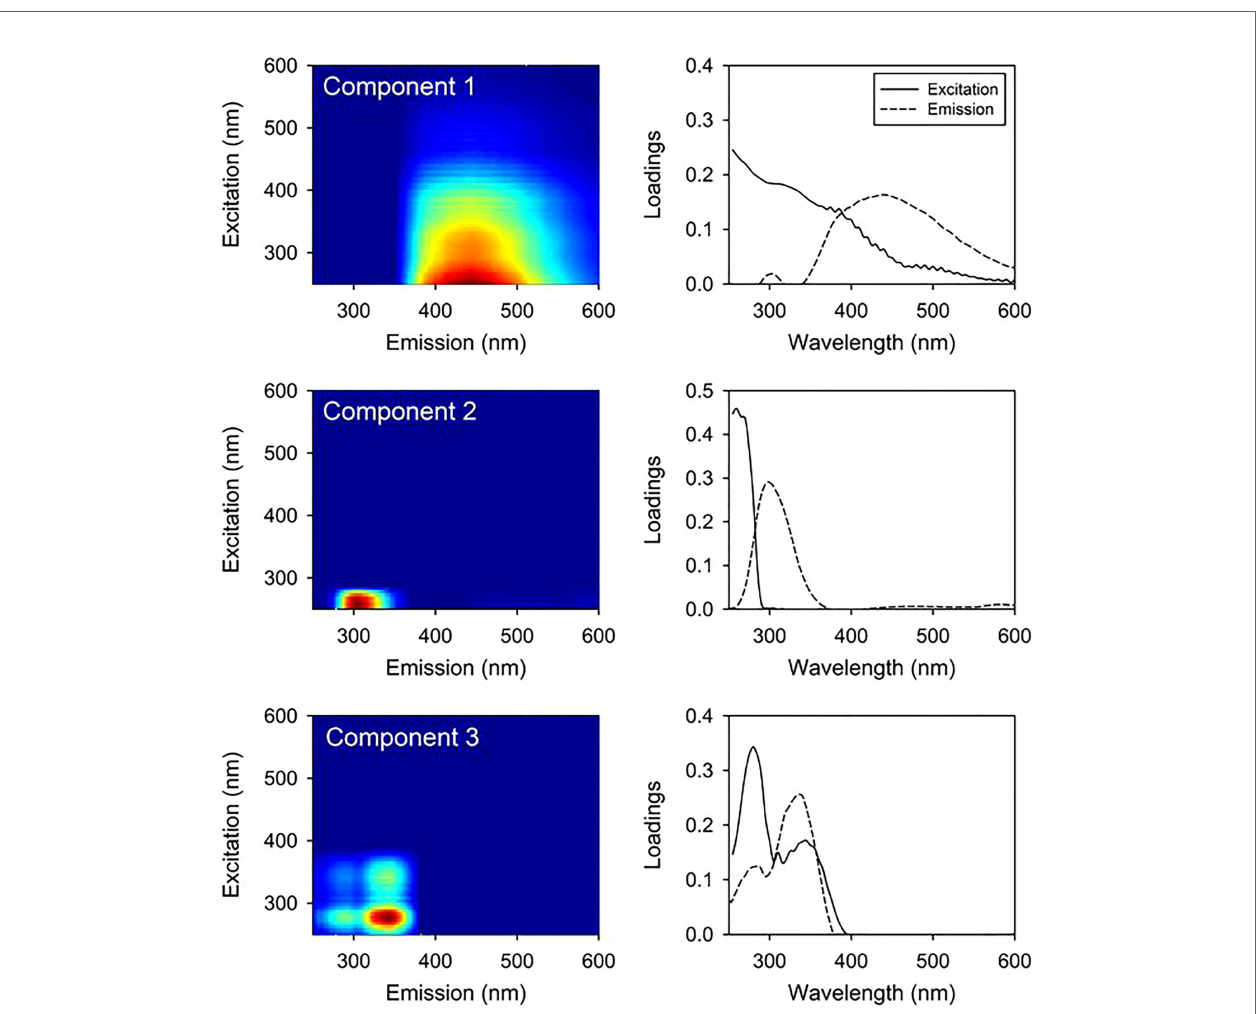
FIGURE 3 | Excitation – emission matrix spectroscopy (EEMs) contour plots and loadings of three components (Component 1, Component 2, and Component 3) identi fi ed using the Parallel Factor Analysis (PARAFAC) model. The solid line indicates the emission wavelength, and the dotted line indicates the excitation